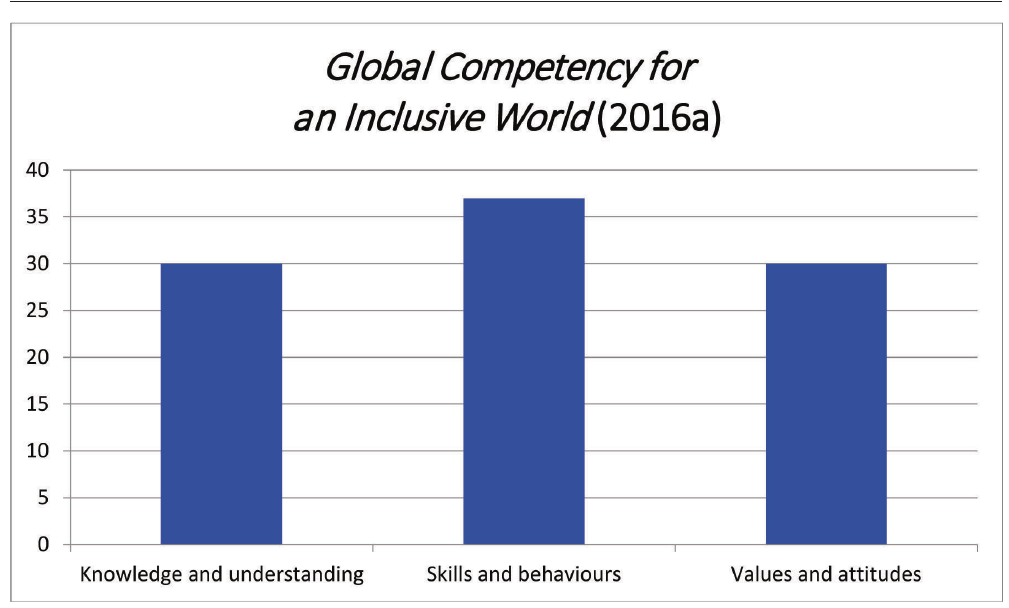
Figure 1: OECD (2016a) Cluster 1